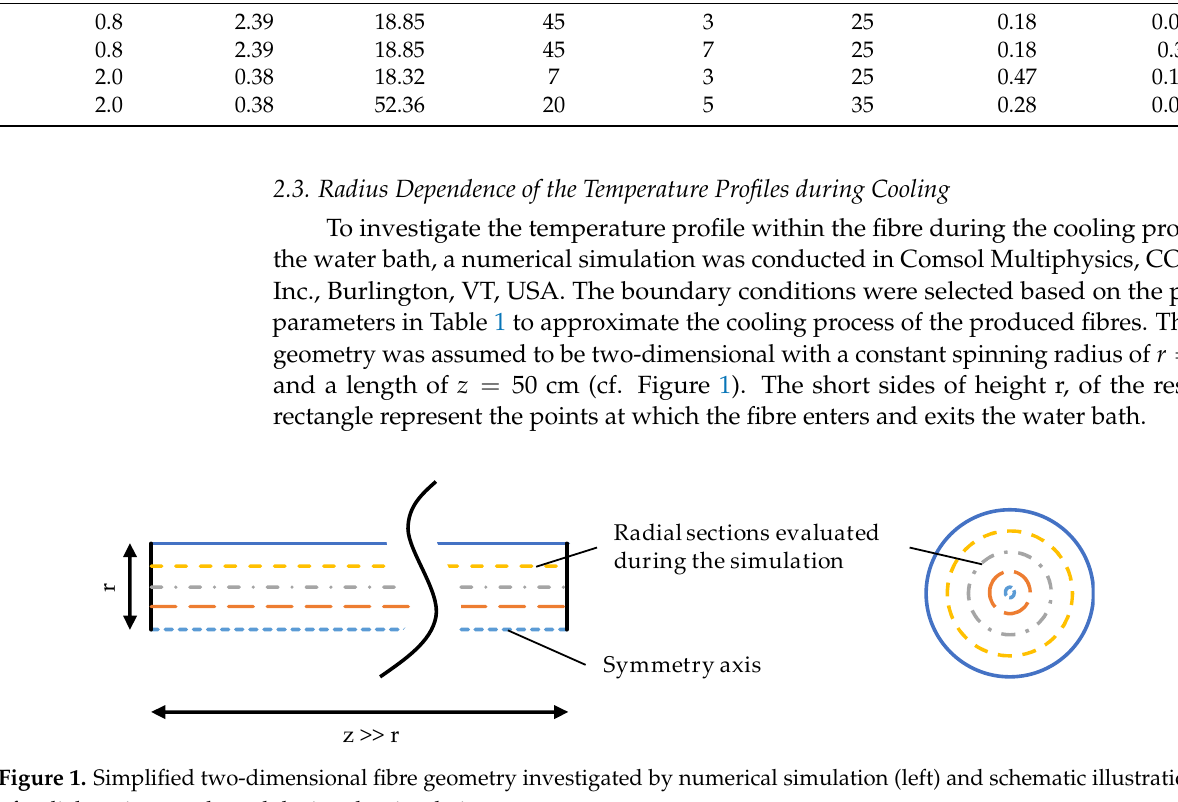
Table 1. Fibre processing conditions of the four polymer optical fibre (POF) samples (see [11] for explanations). No.